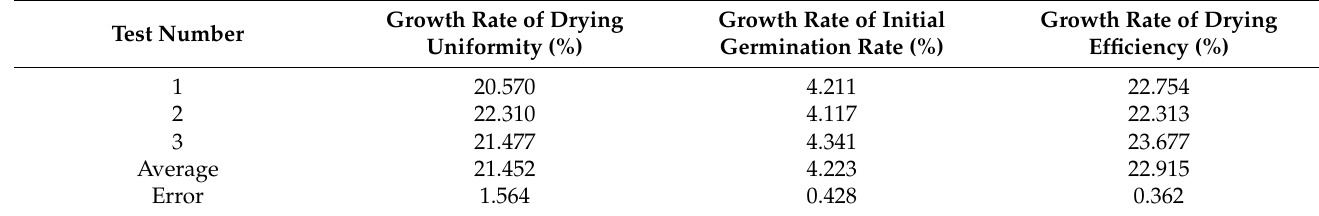
Table 6. The results of validation